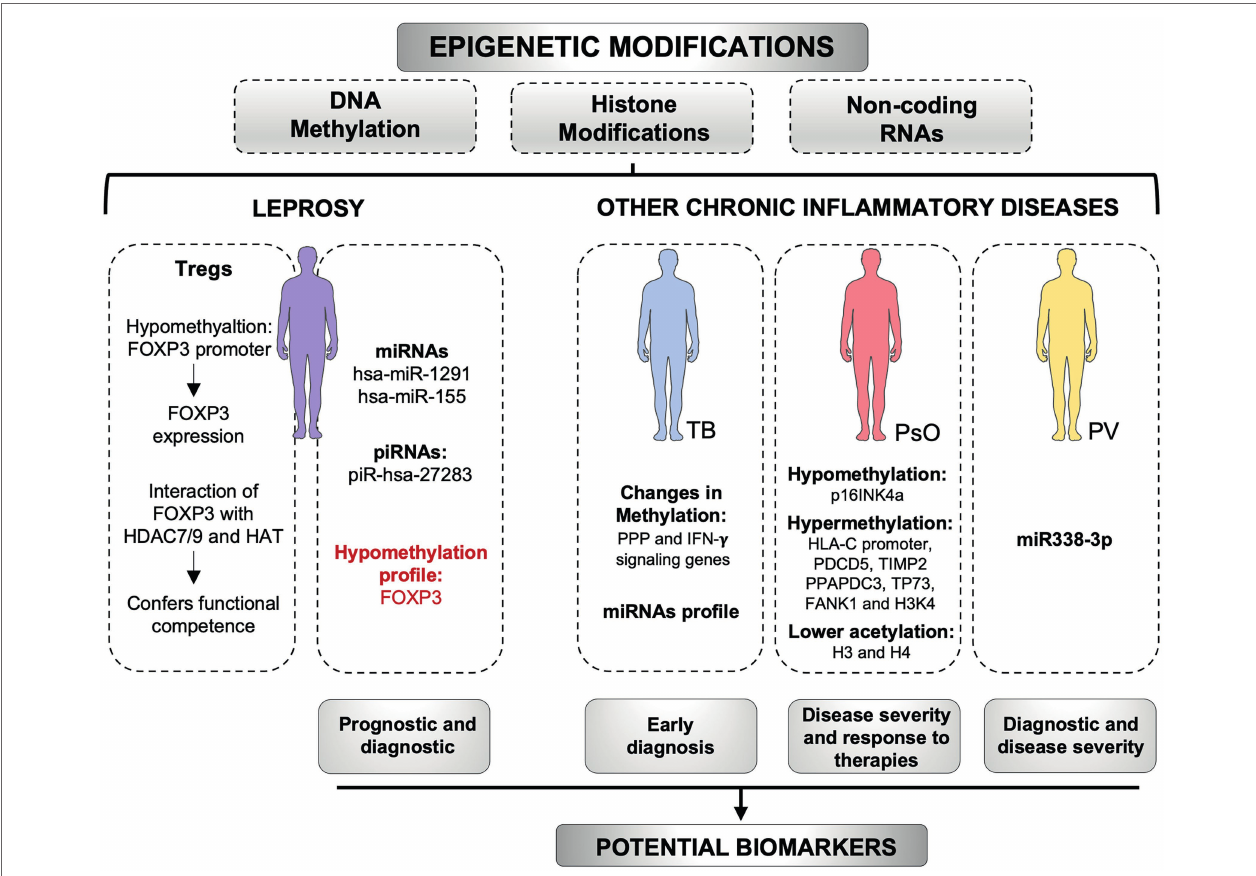
FIGURE 2 | Epigenetic modifications as potential biomarkers. Epigenetic markers, including DNA methylation, histone modifications, and non-coding RNAs, have a great potential as biomarkers for chronic inflammatory diseases. In pemphigus vulgaris (PV), the miR338-3p expression is increased in patients and is positively correlated with disease severity. Changes in the miRNAs profile in tuberculosis (TB), as well as changes in DNA methylation of immune cells genes, may be useful as early diagnostic tools for the disease. In psoriasis (PsO), methylation profile of several genes has been associated with the severity of the disease and response to therapies. In leprosy, hsa-miR-155 and piR-hsa-27283 are upregulated in skin lesions, whereas hsa-miR-1291 is upregulated in the blood of patients. These non- coding RNAs can be tested as biomarkers for the disease. The methylation profile of FOXP3 has been used as a biomarker of prognosis in other diseases and may be used in leprosy as well. However, new studies are required. The levels of FOXP3-HDAC7/9, and FOXP3-HAT complexes in leprosy are associated with functional competence, whereas hypomethylation patterns in FOXP3 promoter support FOXP3 expression. Epigenetic alterations may be useful biomarkers with diagnostic, prognostic, predictive, or therapeutic potential for chronic inflammatory diseases. HDAC, histone deacetylases; HAT, Histone acetyltransferases; PPP, pentose phosphate pathway. Created with